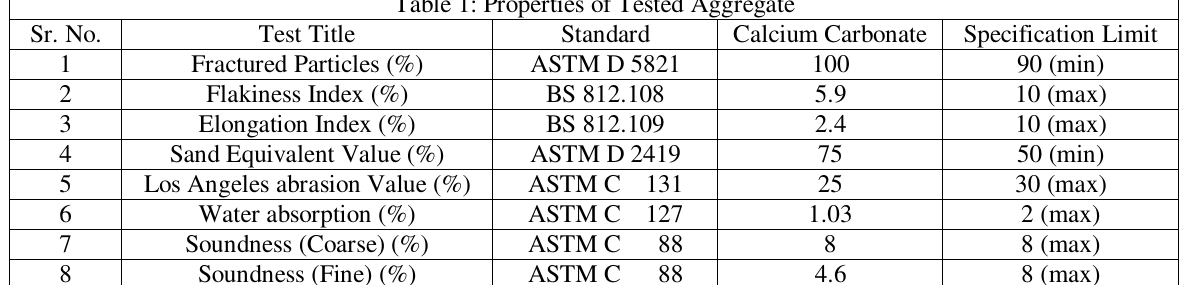
Table 1: Properties of Tested Aggregate